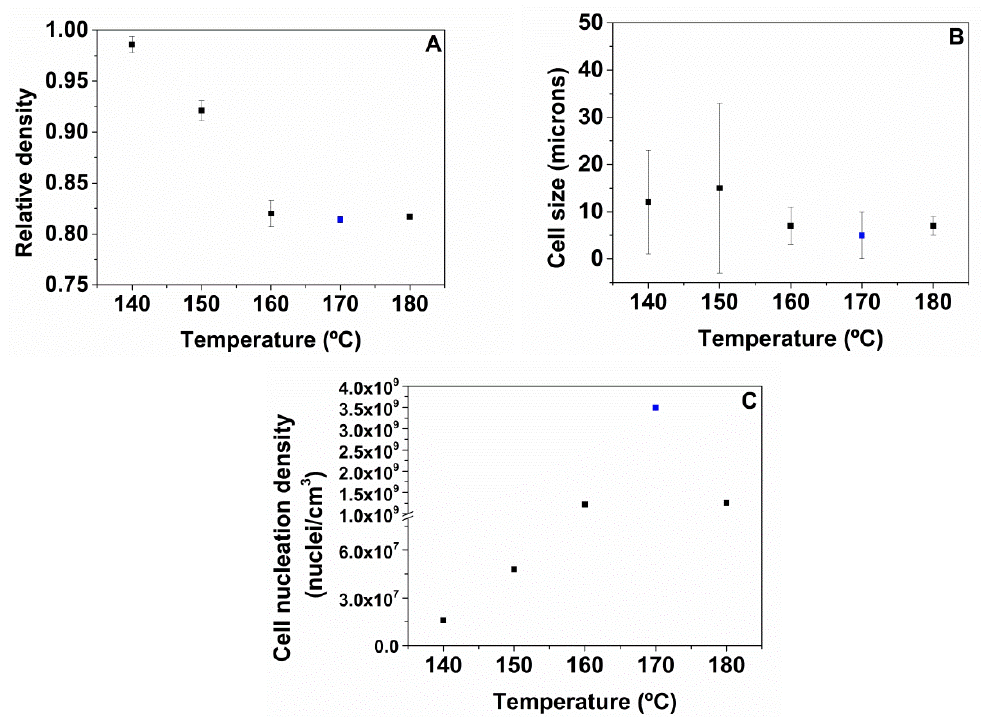
Figure 6. Relative density ( A ), cell size ( B ), and cell nucleation density ( C ) of TPU 50%HS foamed by one-step between 140 and 180 ° C, 20 MPa, and 1 h.